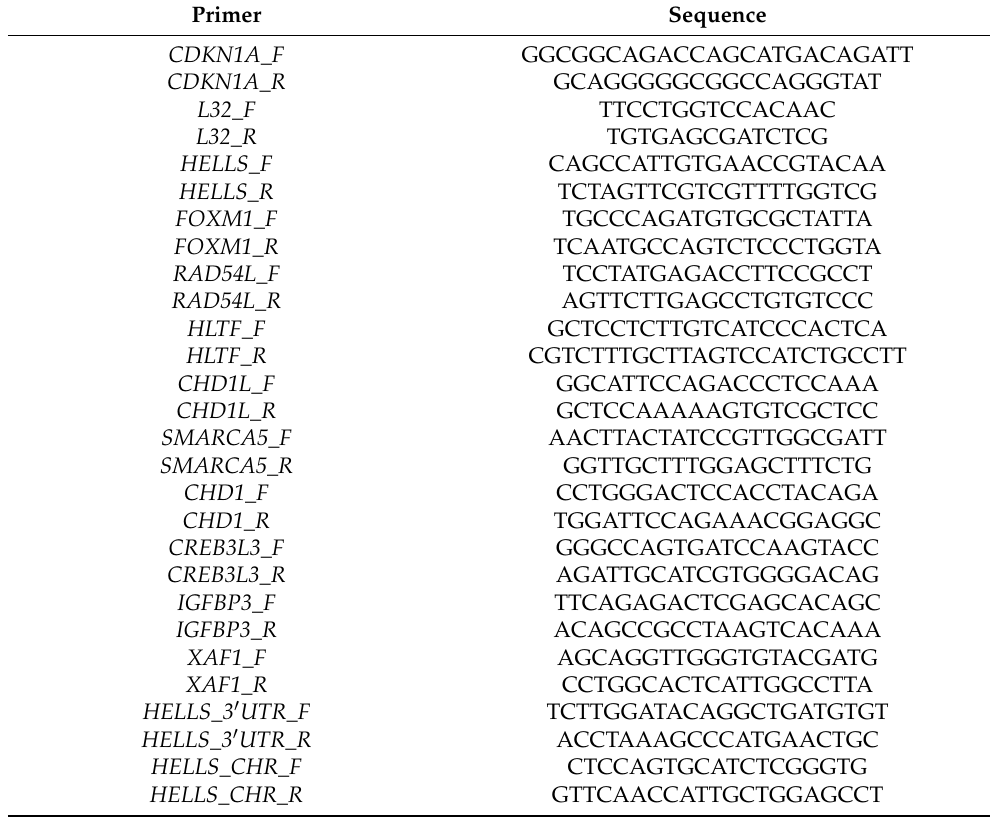
Table 2. Sequences of primers used in the